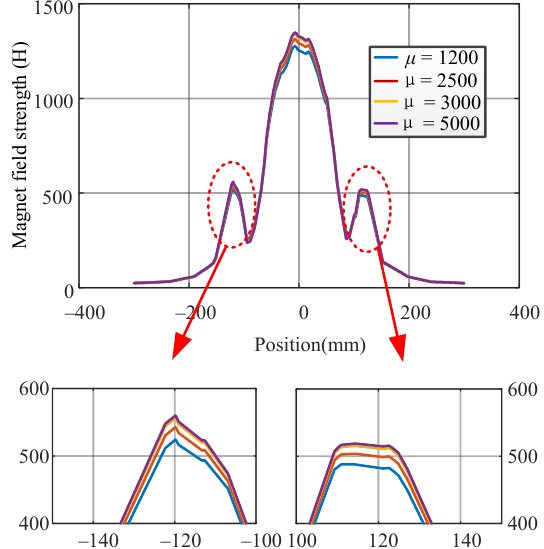
Figure 17. Magnetic field strength curves of shields of NiZn with different relative permeabilities.